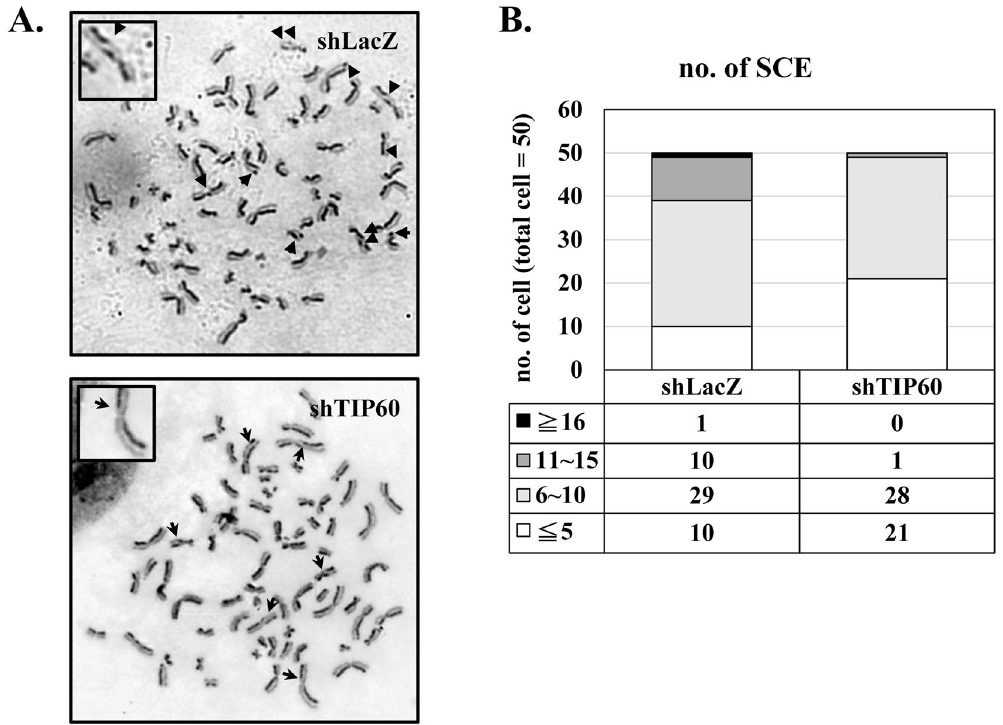
Figure 6. The frequency of sister chromatid exchange is significantly reduced in TIP60-deficient cells. The SCE analysis in the control and TIP60-deficient cells is shown. SCE is indicated by arrows. SCE was scored in at least 50 metaphases of each cell